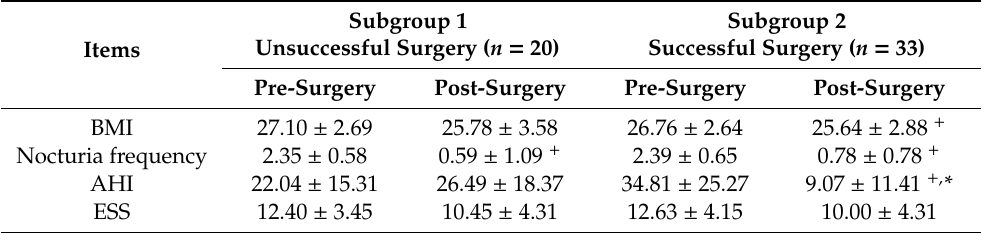
Table 5. Changes in BMI, nocturia frequency, AHI, and ESS only in nocturia patients ( n =